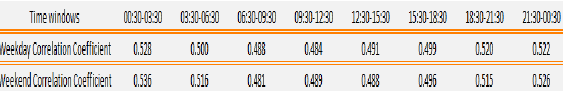
Figure 4. Manhattan Entropy Map